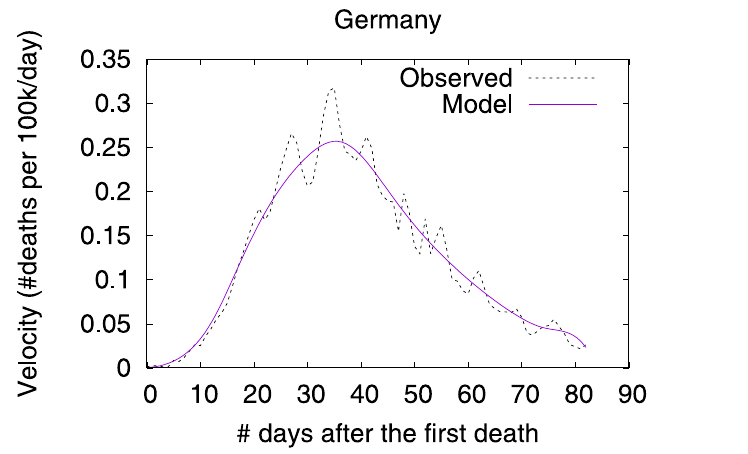
Fig 20. (Color online) projections for velocity in